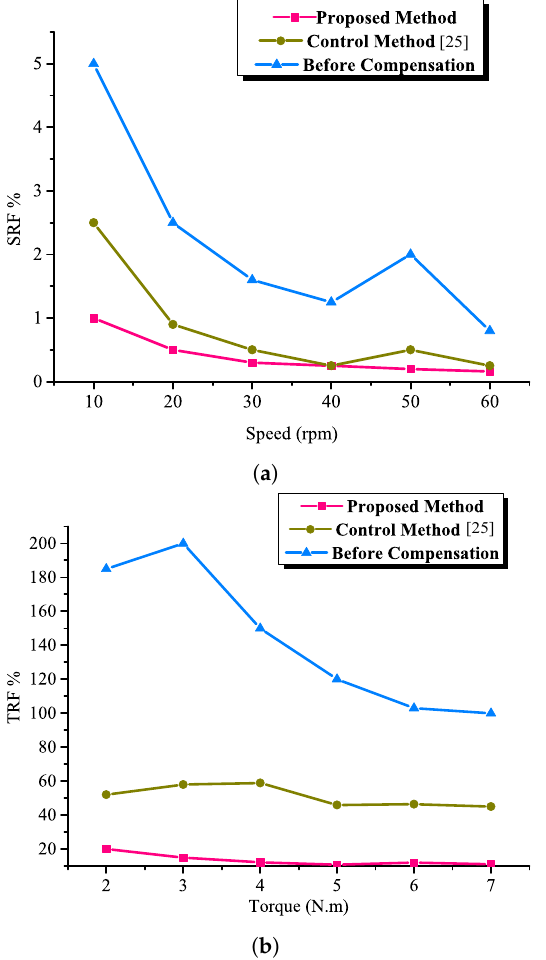
Figure 5. Analysis of SRF for various speed and torque. ( a ) Speed SRF. ( b ) Torque